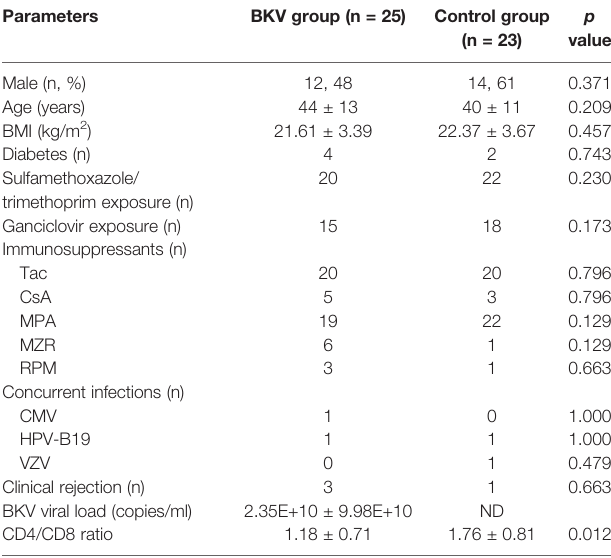
TABLE 1 | The clinical characteristics of the BKV group and the control